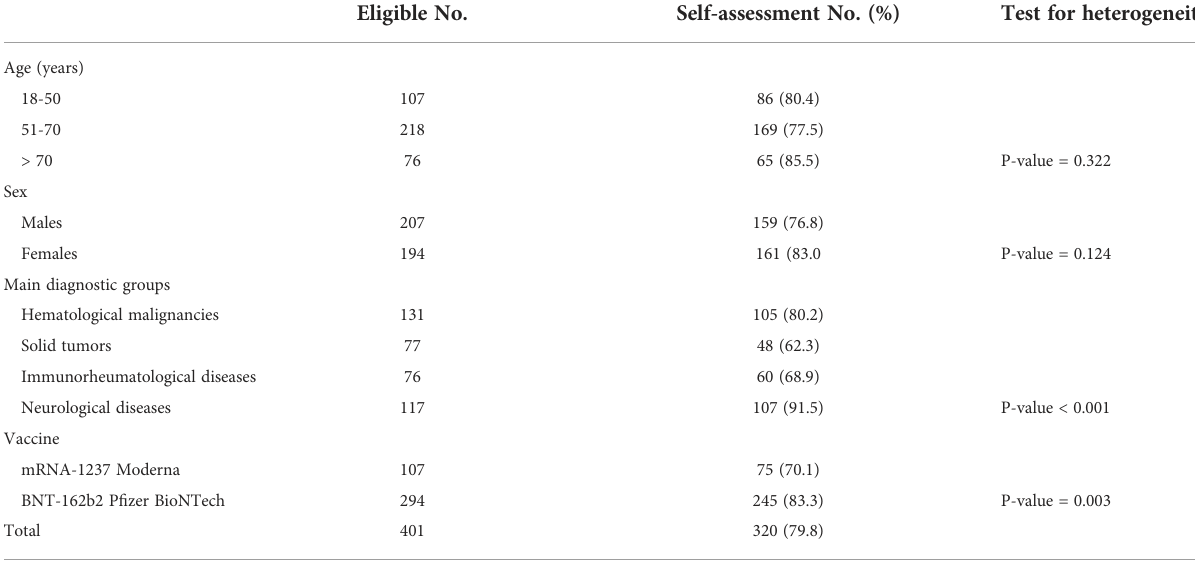
TABLE 1 Eligibility criteria of the four main groups of patients enrolled in VAX4FRAIL study. HEMATOLOGICAL MALIGNANCIES